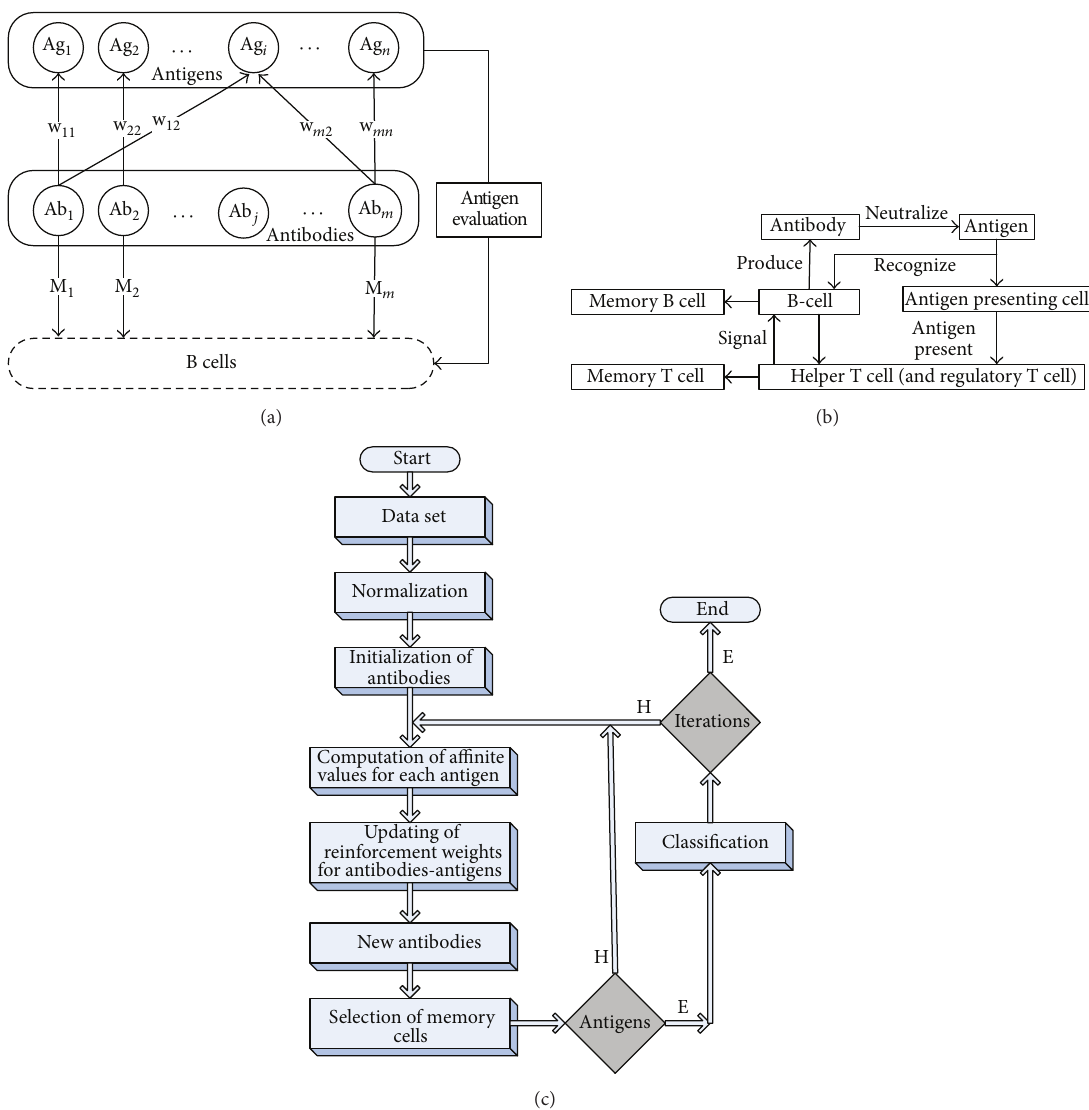
Figure 2: Block diagram and flow chart of the proposed approach.